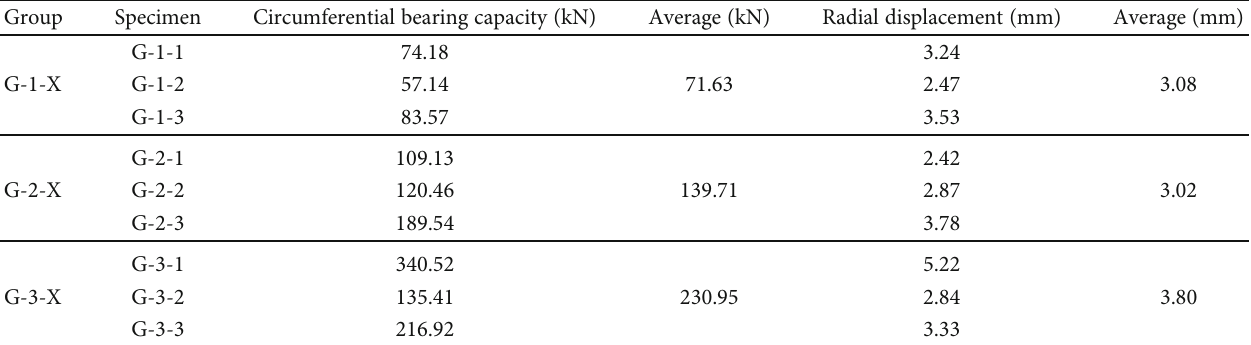
Figure 15: Comparison of circumferential bearing capacity-radial displacement curves of specimens with or without rubber belt: (a) 1-layer prepreg component, (b) 2-layer prepreg component, and (c) 3-layer prepreg component. Table 3: Results of circumferential expansion test of the test group without rubber